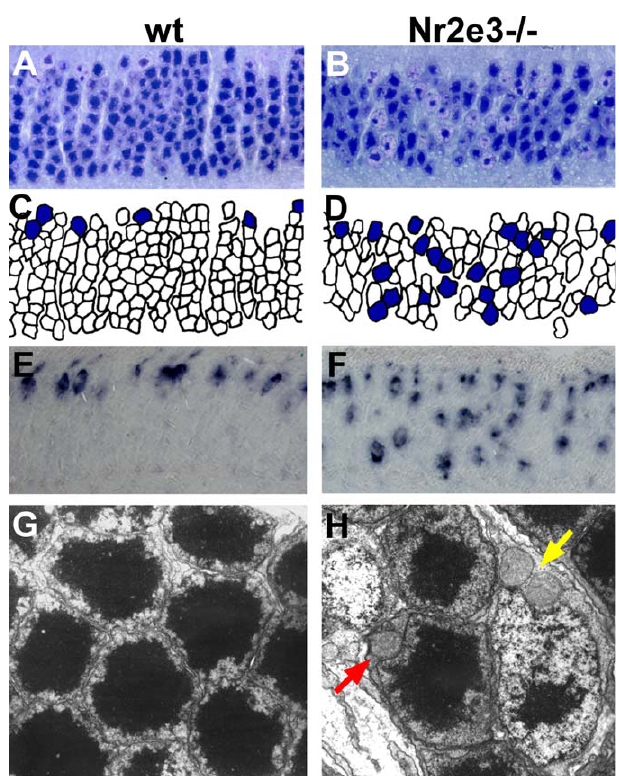
Figure 7. The rd7 Mutant Retina Contains a Morphologically Hybrid Photoreceptor Cell Type in Addition to Supernumerary S-Opsin–Positive Cones (A and B) Toluidine blue-stained semi-thin sections of the outer nuclear layer (scleral edge oriented up). (C and D) Hand-drawn diagrams of the cells in (A) and (B), respectively. Cells with the nuclear features of cones are highlighted in blue. Note that the number of such cells is greater in the mutant, and their cell bodies are scattered throughout the outer nuclear layer. In addition, the overall columnar architecture of the outer nuclear layer seen in the wild type is disrupted in this portion of the mutant retina. Other portions of the mutant retina with fewer supernumerary cone cells, however, retain the normal columnar appearance (unpublished data). (E and F) Images of the outer nuclear layer (scleral edge up) stained by in situ hybridization for S-opsin. Note the typical pattern of staining at the scleral edge of the outer nuclear layer in the wild type. The rd7 mutant retina shows supernumerary S-opsin–positive cells scattered throughout the outer nuclear layer in a distribution very similar to the supernumerary cone cells seen in (B). Since images (E) and (F) derive from different retinas than those depicted in (A) and (B), the location of the individual cells do not correspond. (G and H) Electron micrographs of the outer nuclear layer (10,000 3 magnification). Note the uniform distribution of rod cell bodies in the wild type (G). The cell bodies are nearly round and consist almost exclusively of a nucleus with a single, dense mass of heterochromatin. In the rd7 mutant (H), two types of cell are shown. The ovoid one with a lesser quantity of heterochromatin, paler euchromatin, and two juxtanuclear mitochondria (yellow arrow) represents a typical cone cell body. The adjacent cell with a more ‘‘ rod-like ’’ mass of heterochromatin and a single juxtanuclear mitochondrion (red arrow) represents one of the hybrid photoreceptors discussed more fully in the main text. DOI: